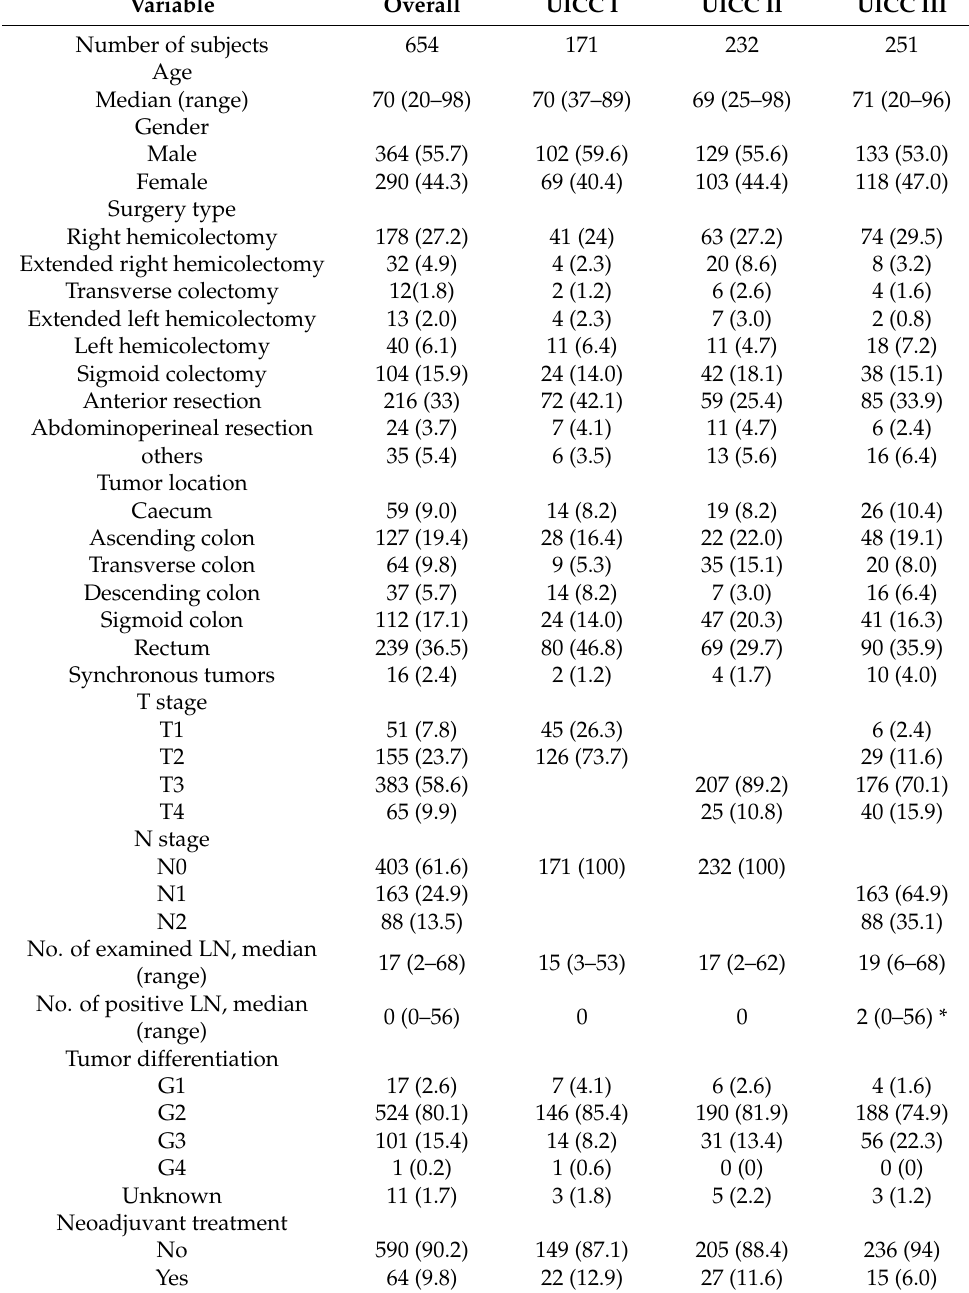
Table 1. Patient